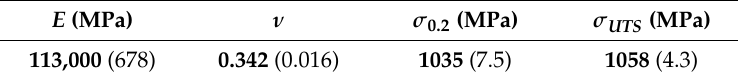
Table 1. Ti-6Al-4V tensile parameters.